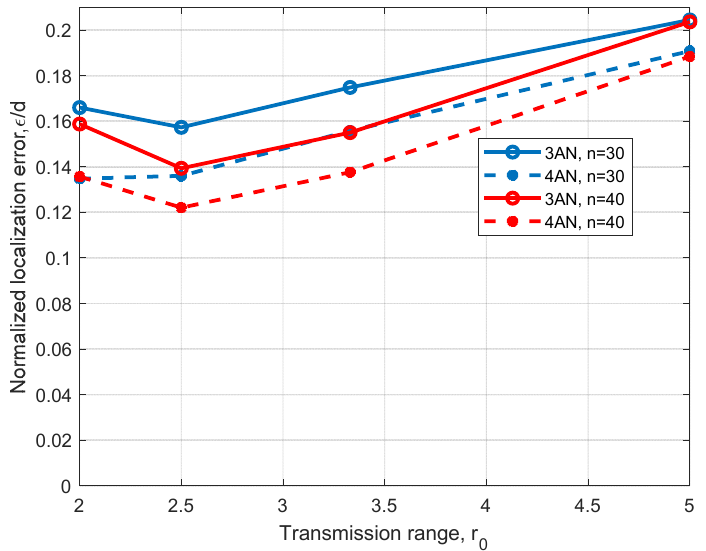
Figure 6. Error analysis for different transmission ranges, r 0 , using three and four ANs in a 2D scenario with d = 10m, n = 30, and n = 40 nodes.